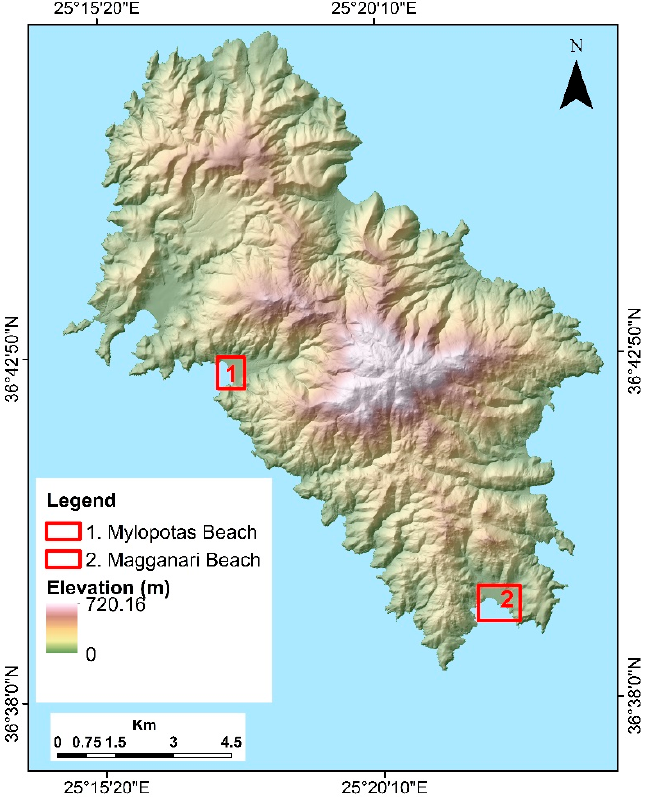
Figure 1. Location of study areas. In the west Mylopotas beach, while in the south is Magganari